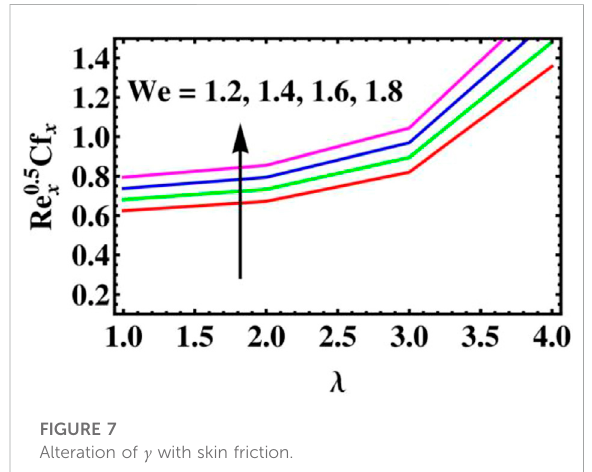
FIGURE 10 Alteration of Ω with motile microorganisms.